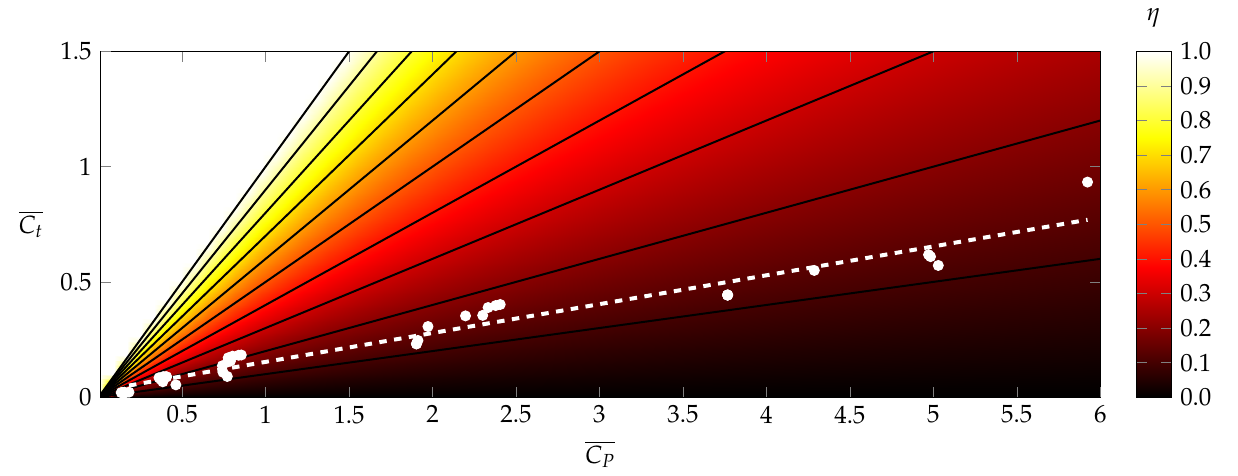
10 3 . Propulsive efficiency is given by the contour plot. ×